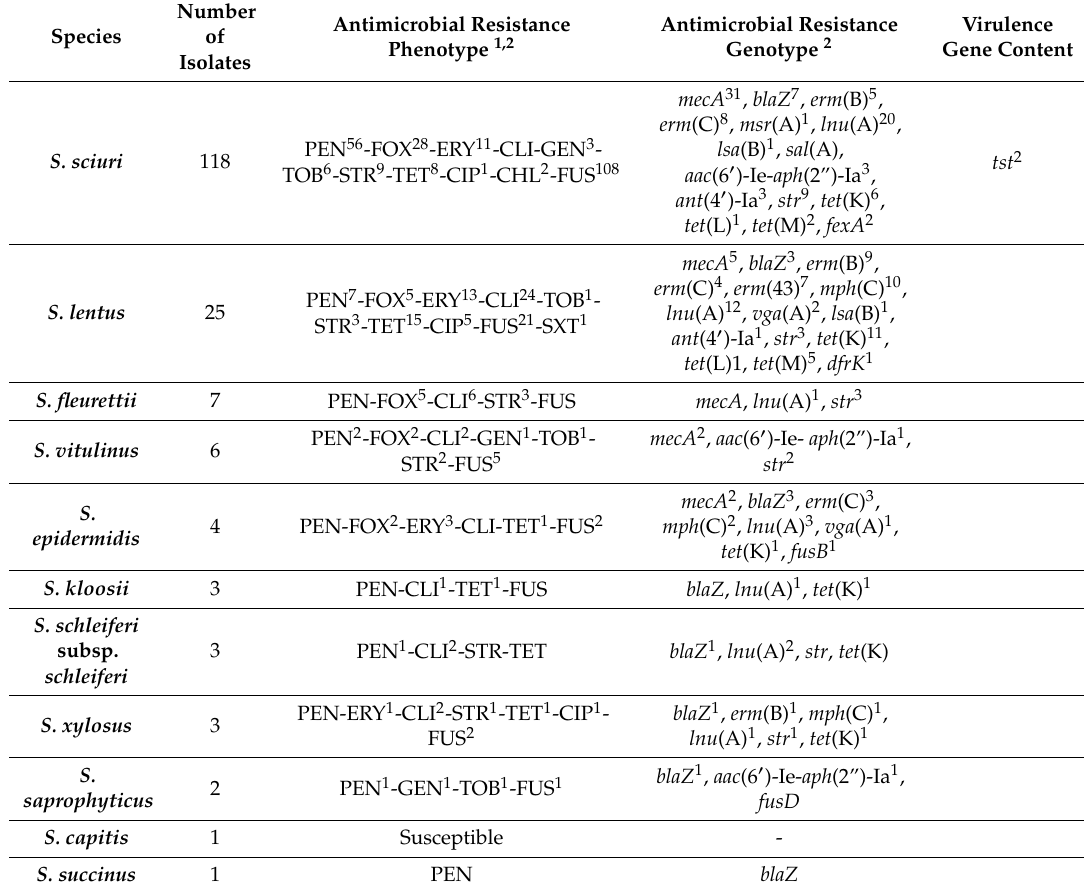
Table 3. Antimicrobial resistance phenotype and genotype and virulence gene content in the CoNS recovered from wild